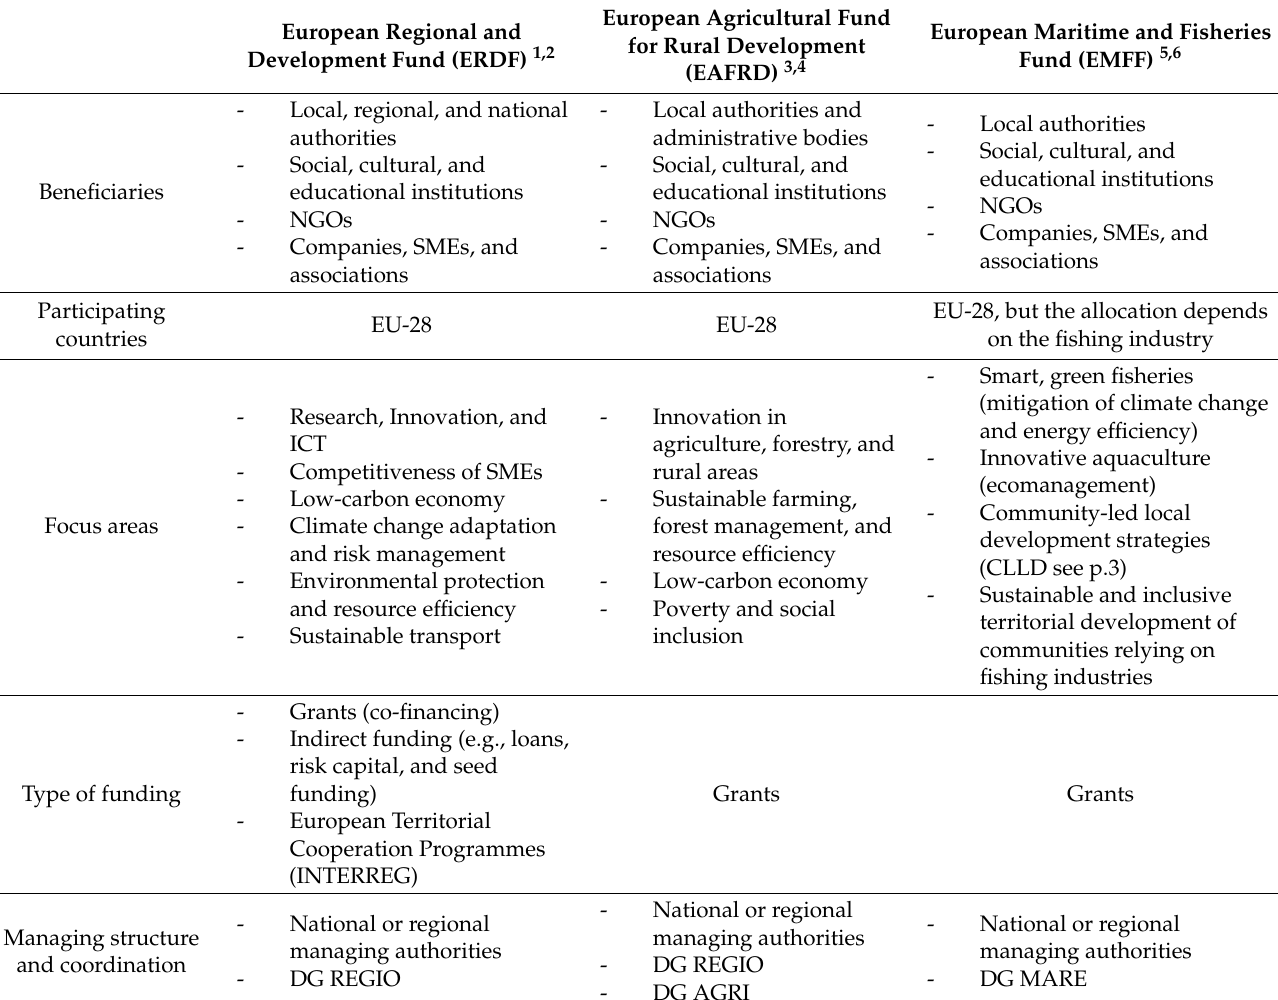
Table A1. European Structural and Investment